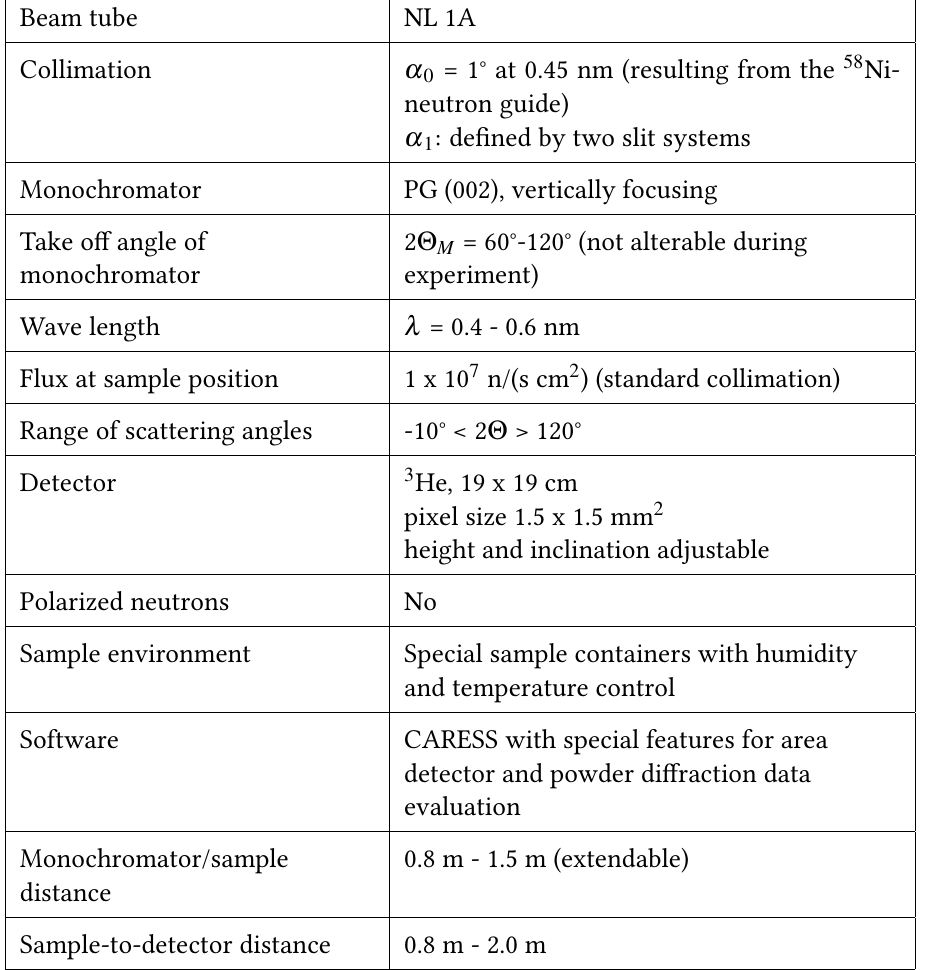
Table 1: Technical parameters of